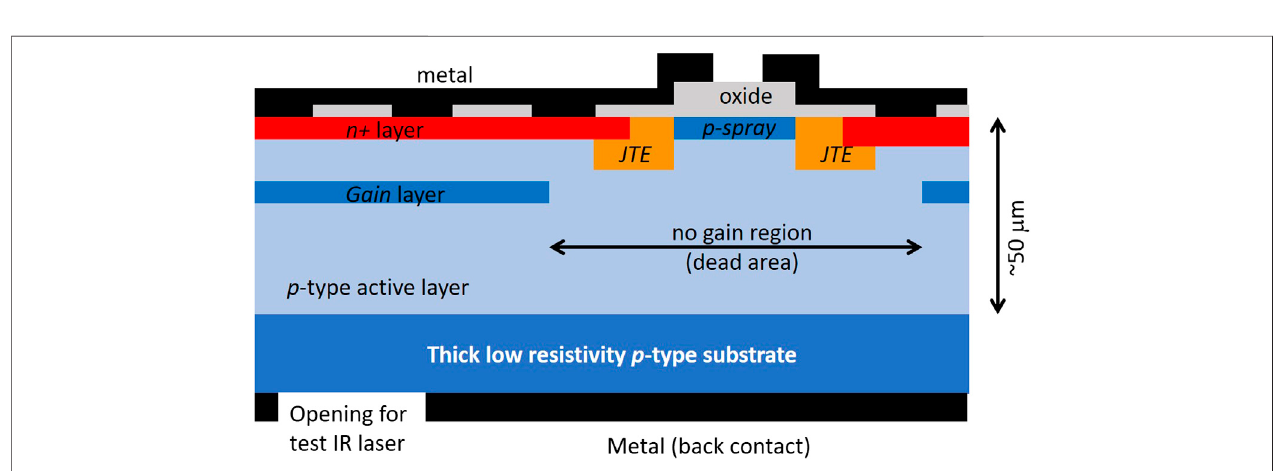
FIGURE 2 | Simpli fi ed cross-section of an LGAD, not to scale. The p -spray isolation implant between pixels can be replaced by a p -stop implant.